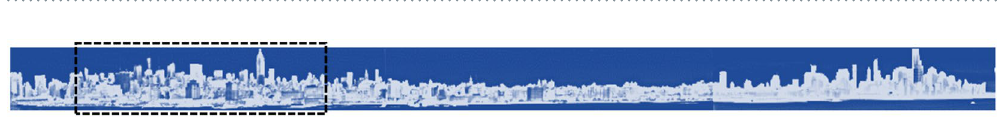
Figure 1. Non-simultaneous composite of compounds detected over Midtown Manhattan. Data cubes post- processed using HyperSEAL software (Aerospace Corp).